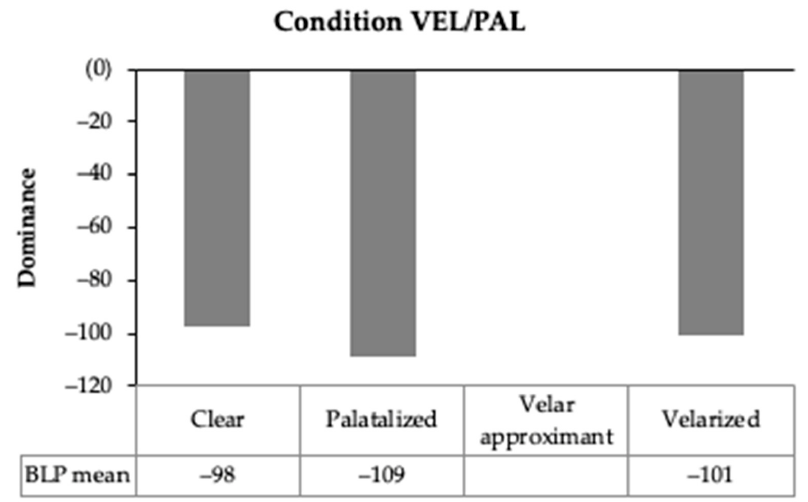
Figure 9. The interaction effect of condition VEL/PAL and language dominance.